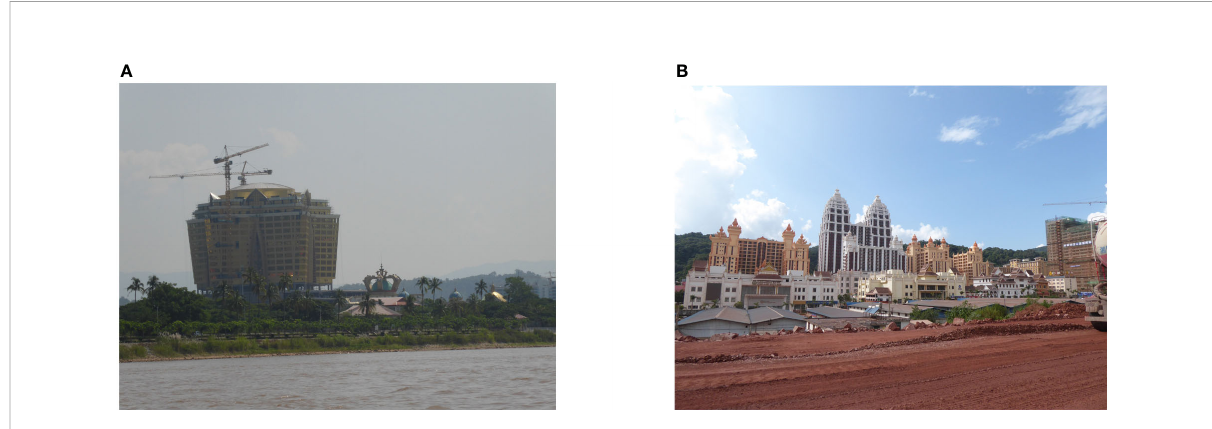
FIGURE 2 (A) The Golden Triangle SEZ, 2019; (B) Boten SEZ, 2019.